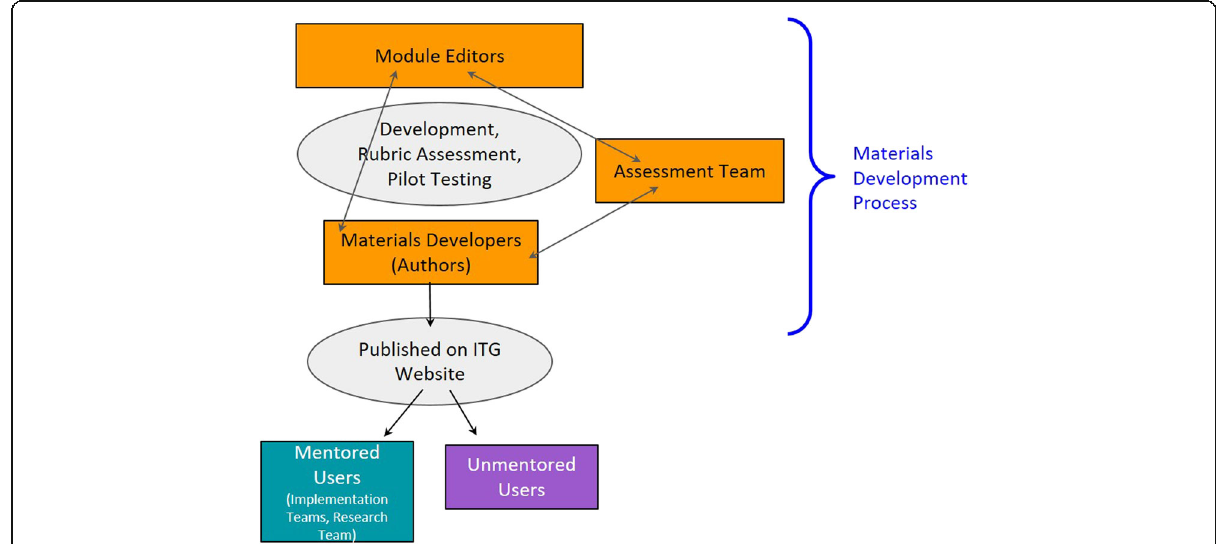
Fig. 3 Flow chart with arrows show relationships among materials development (grey arrows) and publication and use of ITG materials (black arrows). Colored boxes indicates the categories of ITG users who were observed with RTOP, including materials developers (orange), mentored users (teal), and unmentored users (purple). Color coding is the same in Fig.